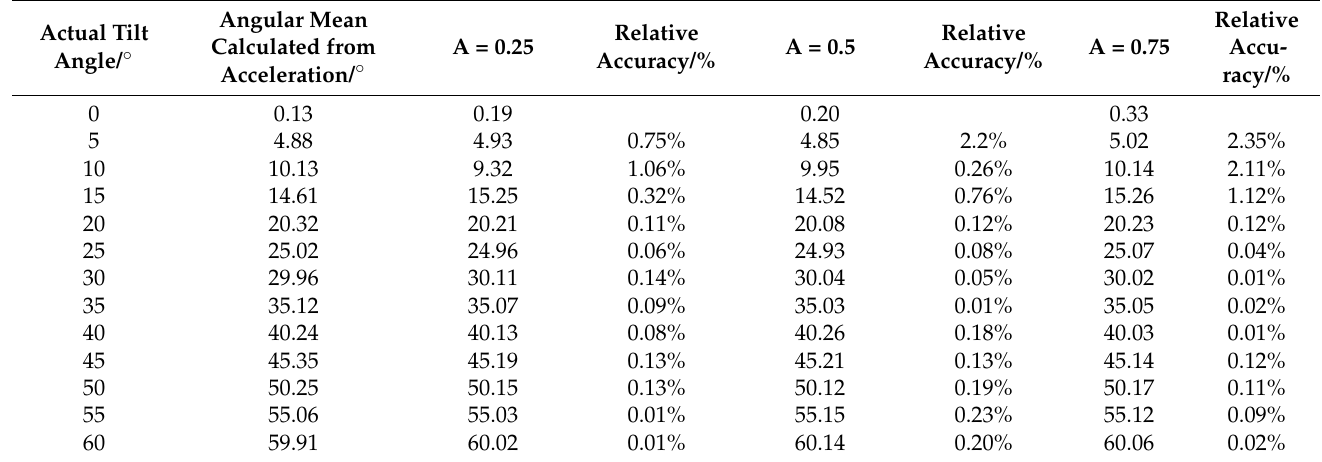
Table 3. Comparison of tilt angle data under different filtering coefficients.